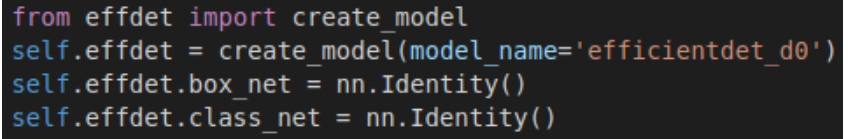
Figure A4. Removing the classification and the regression heads from the EfficientDet. Source: https: //github.com/Keredu/Intracranial-Hemorrhage-Detection/blob/main/src/model.py, accessed on 16 November